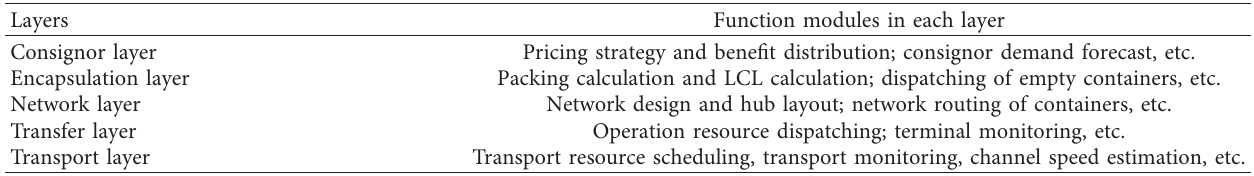
Figure 1: Intermodal transport cooperation protocol. Table 1: Function modules in each layer.